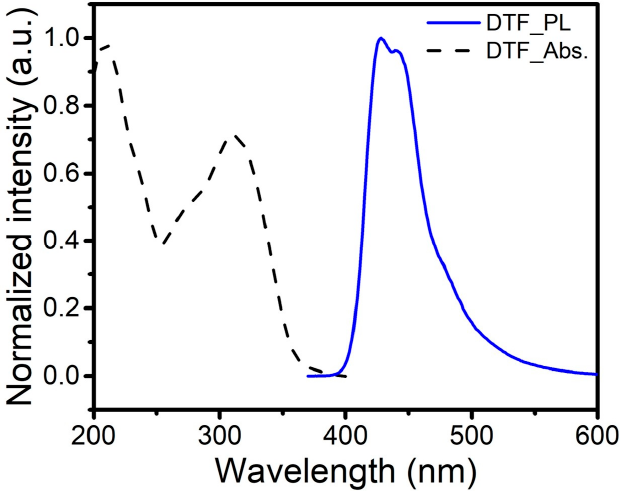
Figure 2. The calculated HOMO and LUMO distributions of DTF and molecular structure of materials used in devices.